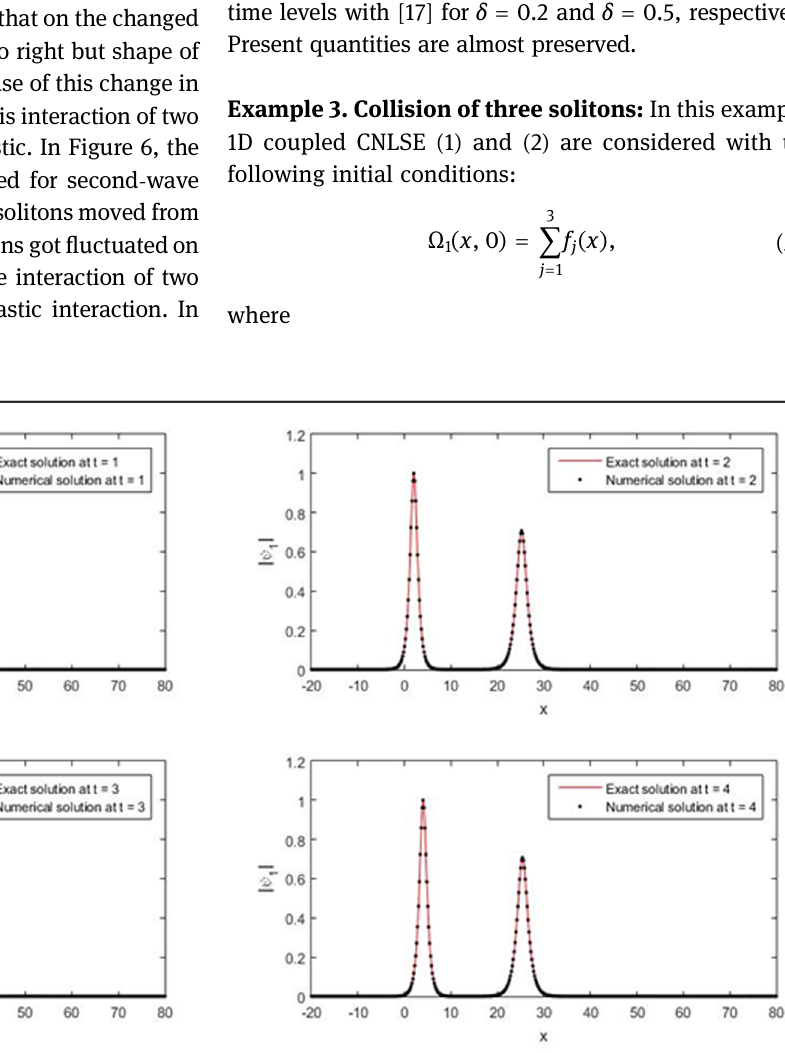
Figure 7, the interaction of two solitons is shown for fi rst - wave amplitude. In this interaction, higher - amplitude wave crossed lower - amplitude waves and moved from left